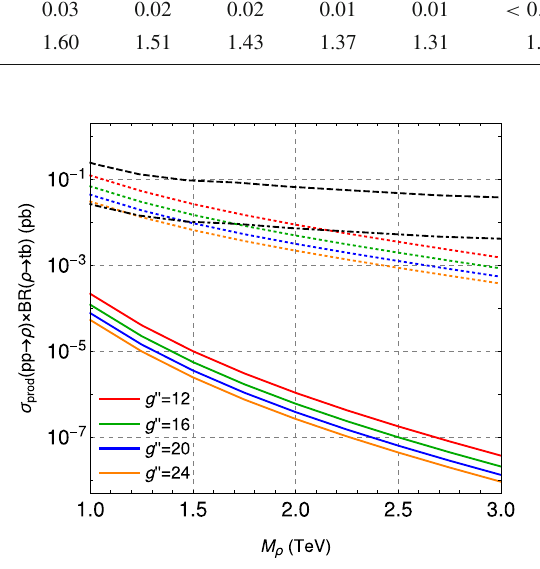
Fig. 9 The plots of σ prod × BR predicted by the tBESS model for the tb channel when there are no direct interactions (colored solid lines) and when BR (ρ → tb ) = 1 (colored dotted lines) along with the relevant experimental upper bounds (black dashed line) as functions of M ρ . The black dot-dashed line depicts the expected upper bound for the integrated luminosity 3000 fb − 1 . The predicted cross sections are shown for four different values of g (cid:2)(cid:2) : 12 (red), 16 (green), 20 (blue), 24 (orange). They decrease with g (cid:2)(cid:2) . The 13 TeV collisions of protons are